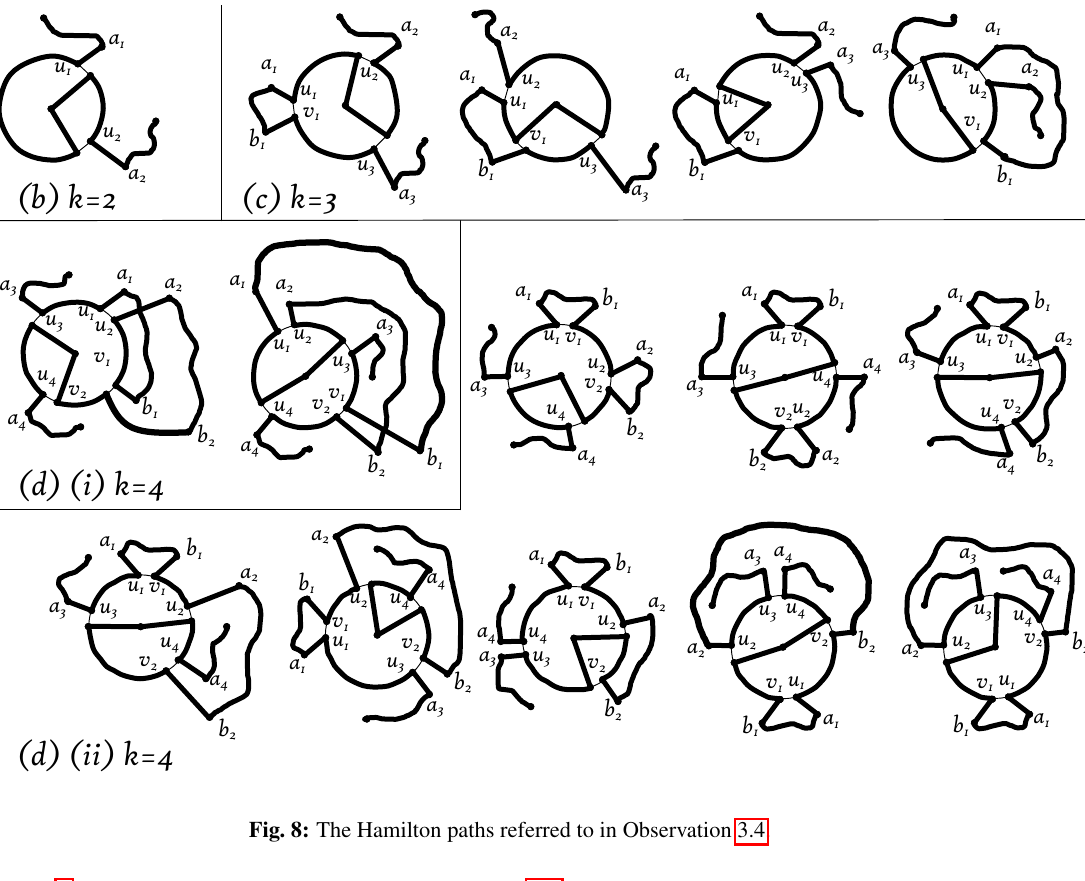
Fig. 8: The Hamilton paths referred to in Observation